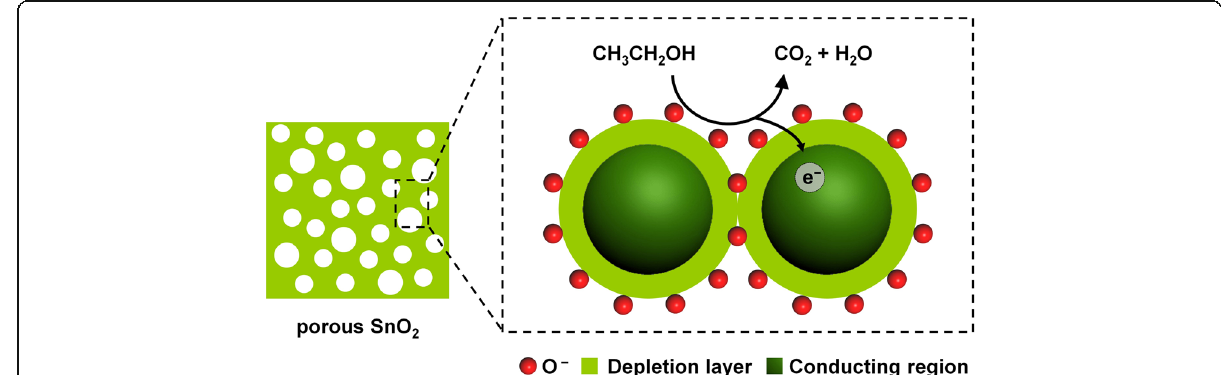
Fig. 8 Schematic illustration of ethanol sensing mechanism of mesoporous SnO